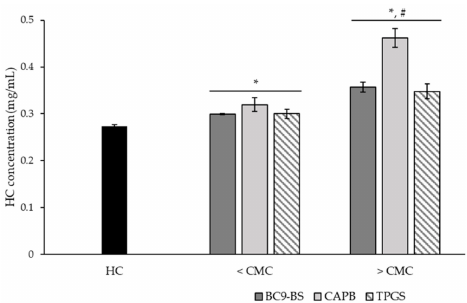
Figure 2. Surfactants influence on hydrocortisone (HC) solubility at room temperature (25 ◦ C) when used at concentrations below (<) and above (>) the respective critical micelle concentration (CMC). Data are expressed as means ± SD, n = 3. Significance indicated by * = p < 0.05 with respect to HC solubility without surfactants (black bar), by # = p < 0.05 compared to HC solubility in the presence of the same surfactant at a concentration <